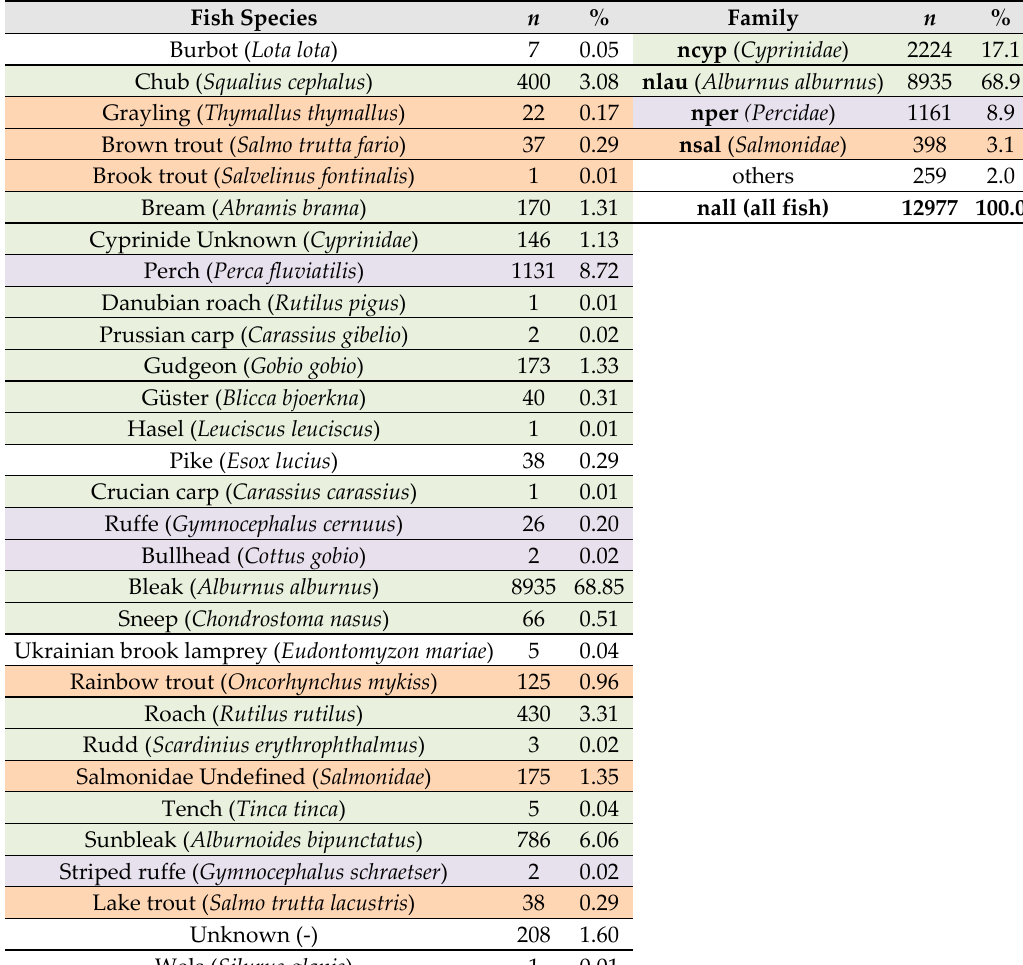
Table 5. Overview of fish species and family of detected fish at the entrance of the fish pass.